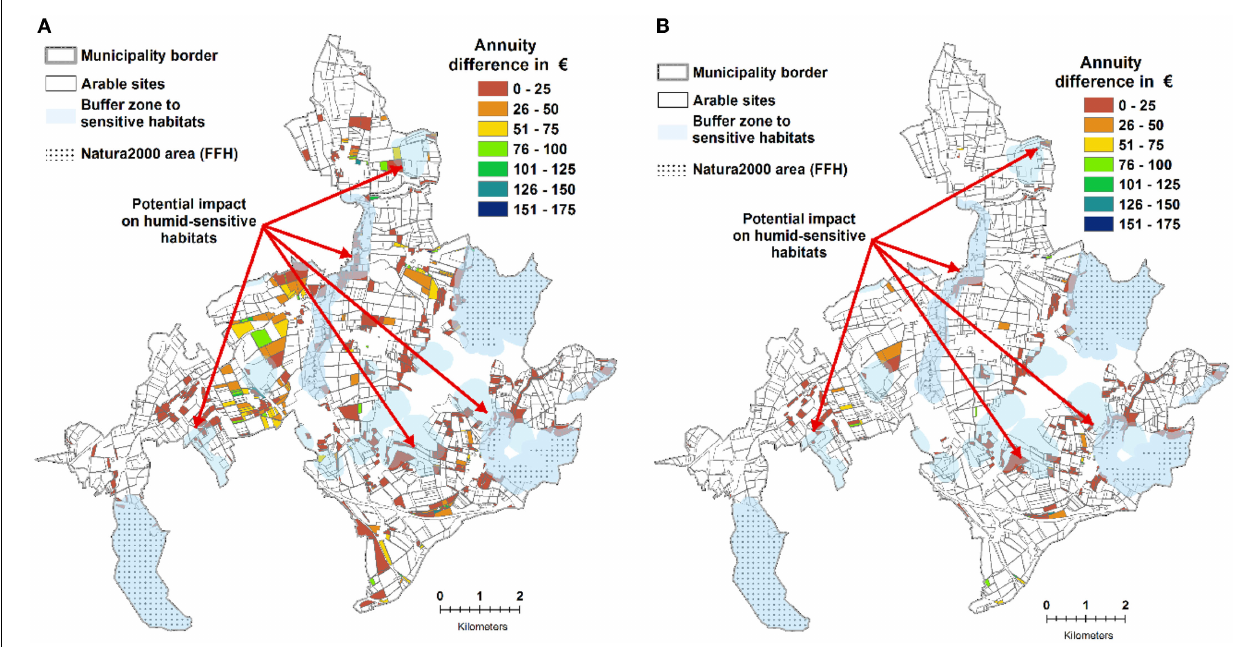
FIGURE 8 | (A) Economically competitive SRC sites, (B) economically competitive SRC sites that provide cross compliance-relevant erosion protection. (A) additionally depicts layers addressing potential restrictions for SRC